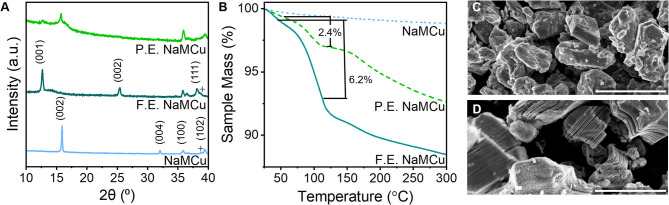
Structural characterization of expanded NaMCu materials. (A) Powder XRD shows the complete transformation of the F.E. material into the hydrated phase, while the P.E. material contains both the hydrated phase and residual P2 phase. (B) TGA shows that both F.E. and P.E. NaMCu materials lose a significant amount of water with increasing temperature. SEM of the (C) pristine NaMCu powder and (D) F.E. NaMCu powder shows that the expanded particles retain their initial hexagonal morphology and particle size but are now expanded along the layers. Scale bar 3 μm.